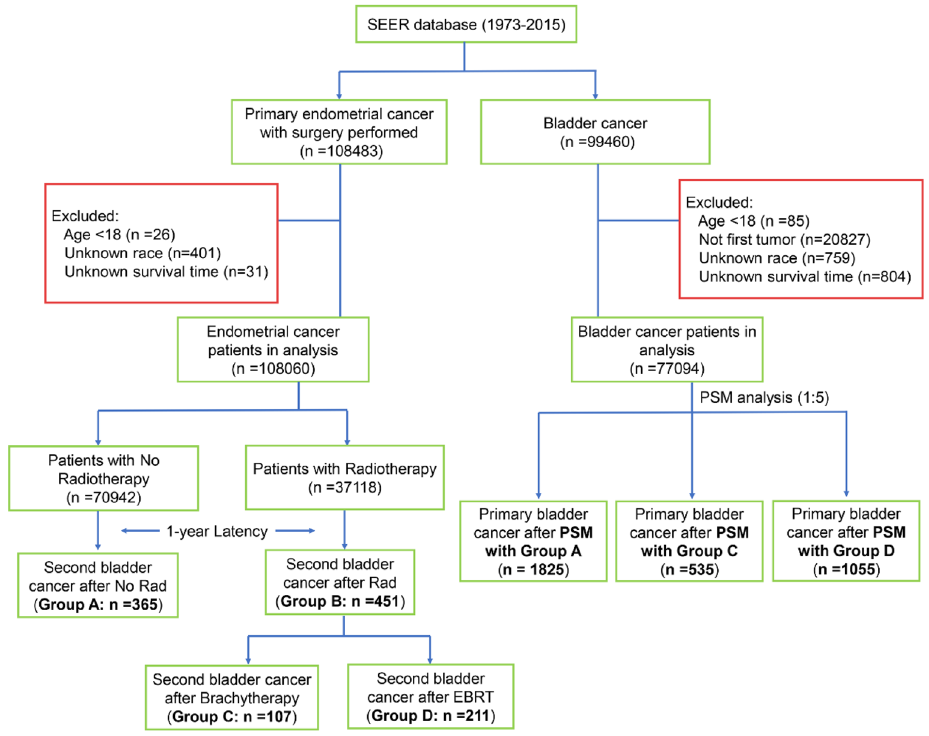
Figure 1. The flowchart of patient